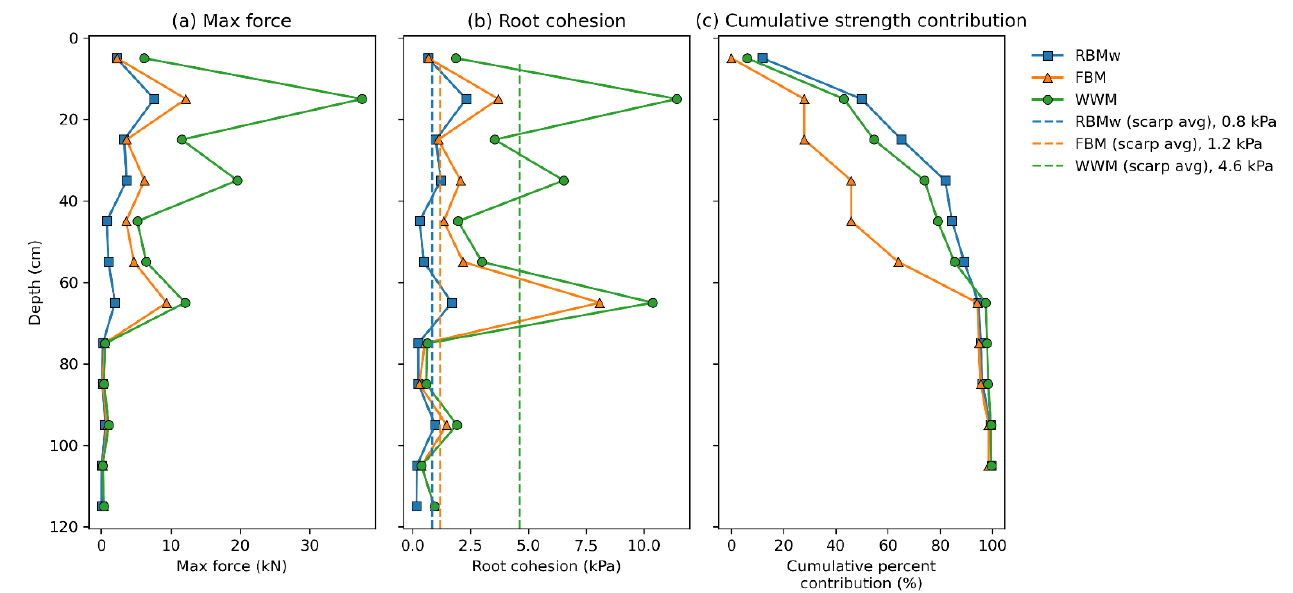
Figure 10. Root strength variation by depth calculated over the perimeter of the landslide scarp. Panel